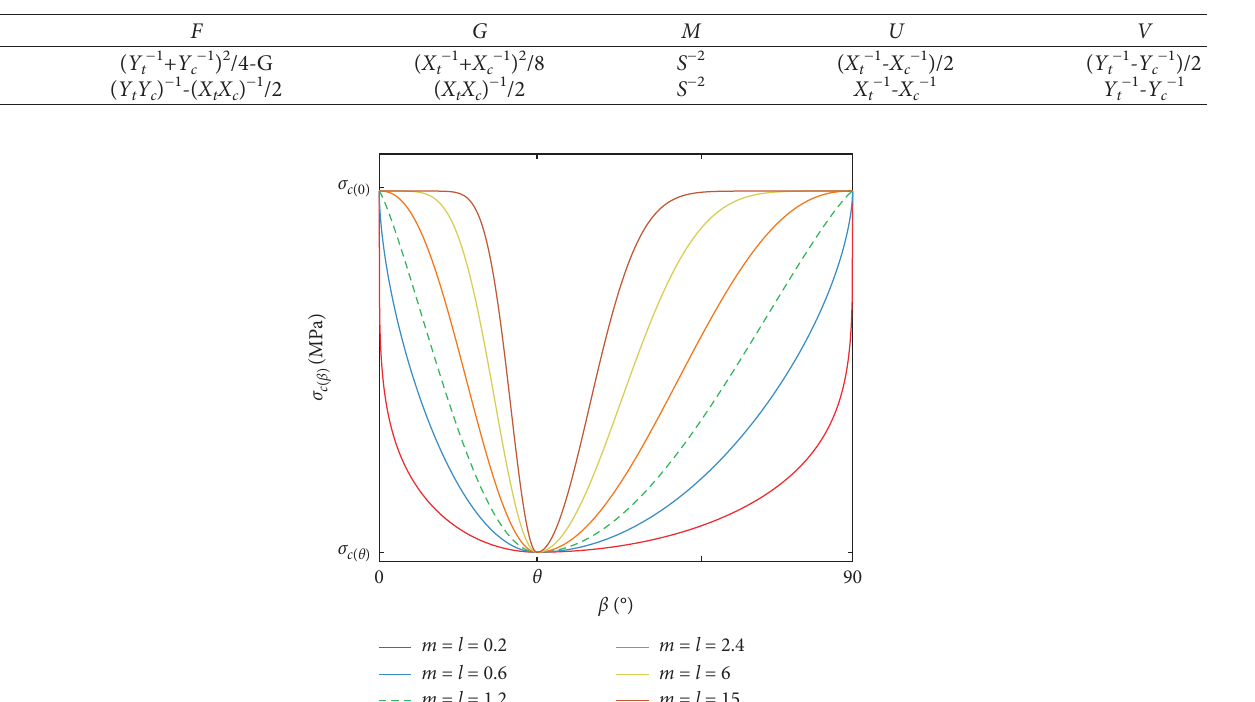
Table 2: The material coefficients of Pariseau’s criteria.